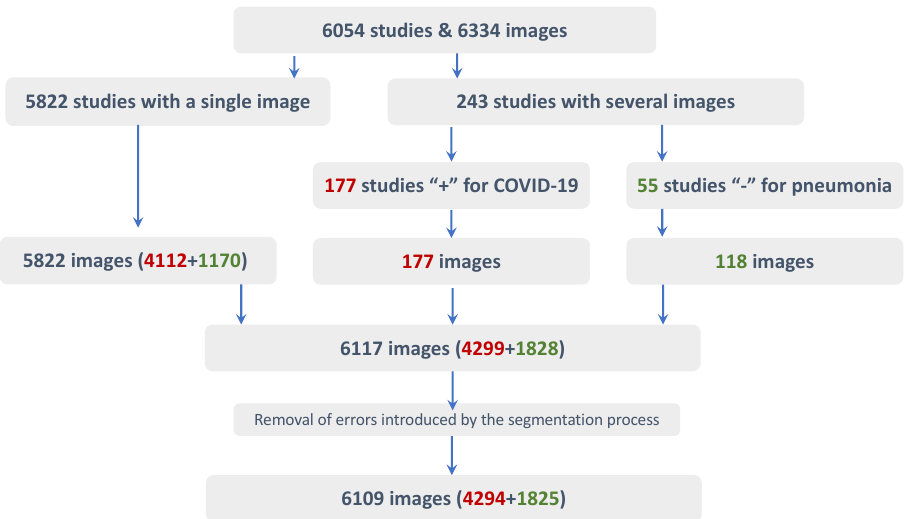
Figure 3. Schema representing the process followed to identify the samples used in the data set. In red, the number of COVID-19 positive samples (labelled with their corresponding bounding boxes). In green, the negative for pneumonia samples (without bounding